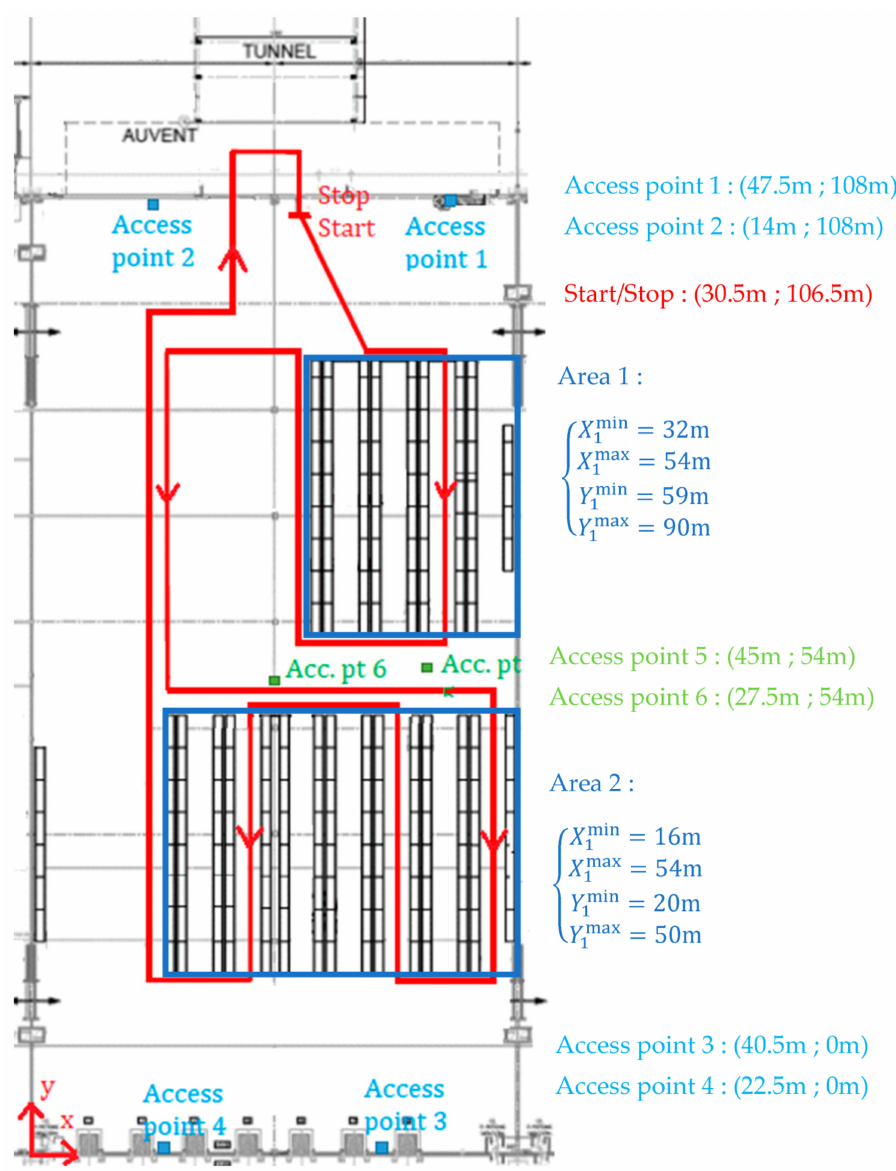
Figure 5. Warehouse under consideration with the 425 m journey done by the robot and the localiza- tion of the different Wi-Fi access points and storage